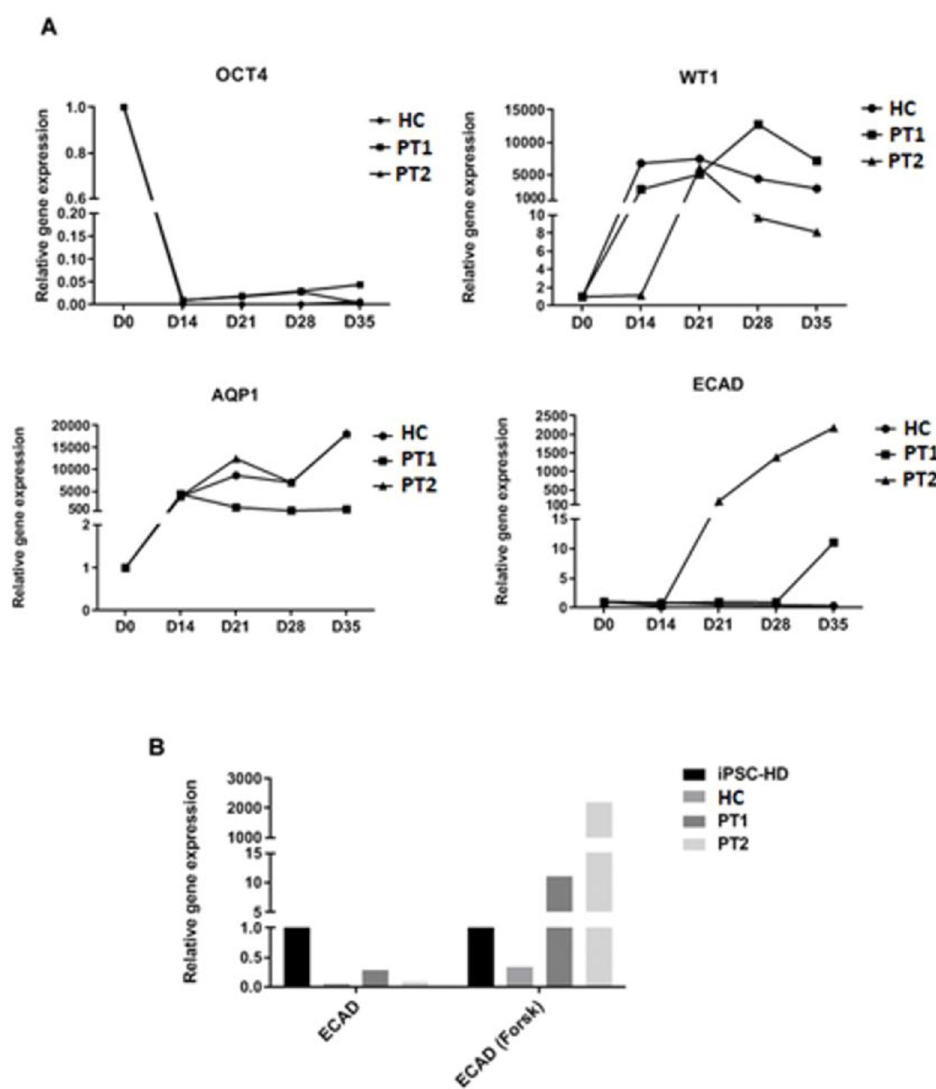
Fig 5. Relative gene expression levels of renal structures. A. Sequential expression of pluripotency and organogenesis markers. Day 0 (D0) refers to iPSCs and OCT4 expression in D0 was used as a quantitative standard for each sample. In this set of experiments, forskolin was added at day 28. B. Expression levels ECAD in the organoids at day 35 in the presence and absence of forskolin (added at day 28). GAPDH was used as an internal control and OCT4 expression by iPSCs from healthy donor (HD) was used as the quantitative standard. WT1 and AQP1 were used as markers of renal structures, and ECAD as the cyst marker.